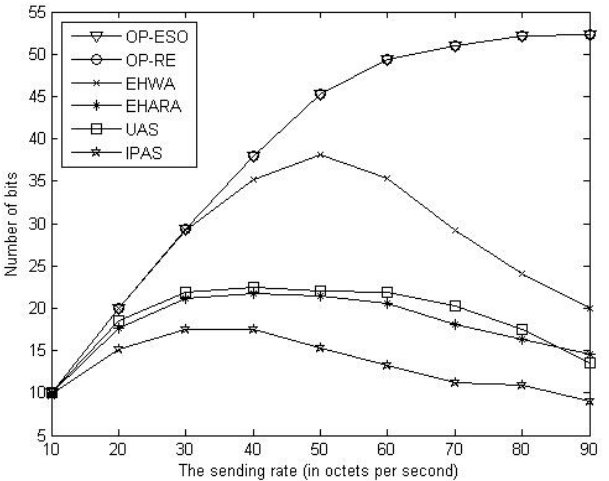
Figure 6. Number of delivered bits vs. data sending rate in medium energy-harvesting rate (MER) case.